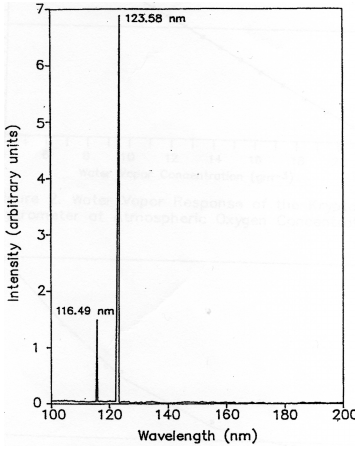
Fig. 1. Spectrum of the krypton lamp (Campbell and Tanner, 1985, courtesy Scientific Services, Rocky Hill,